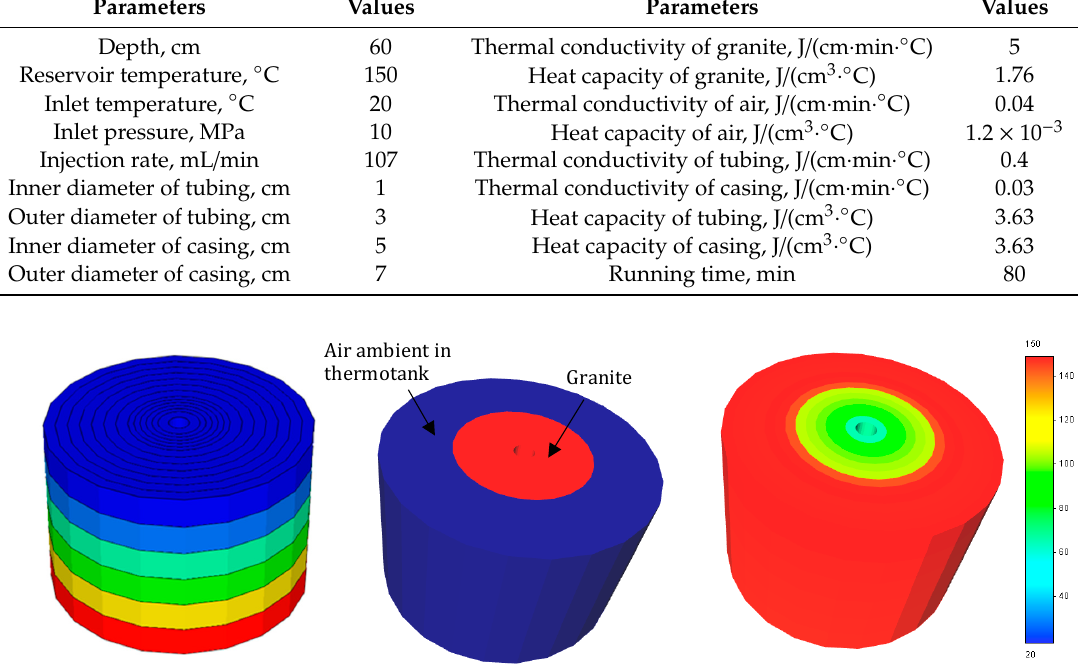
Table 3. Parameter settings of the numerical simulation model of the self ‐ circulation wellbore.